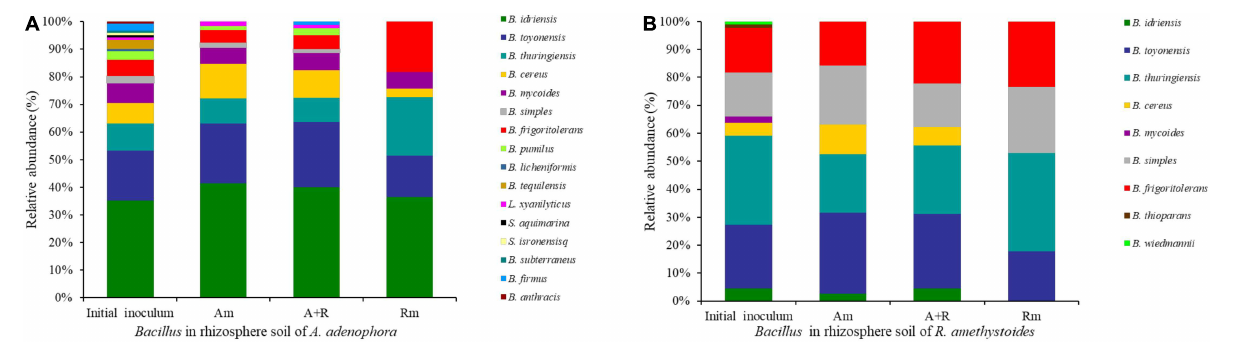
FIGURE 1 | The relative abundance (RA) detected for each Bacillus phylotype in rhizospheric soil of A. adenophora (A) and (B) in different treatments. Am, A. adenophora monoculture; A+R, A. adenophora and R. amethystoides mixture; Rm, R. amethystoides